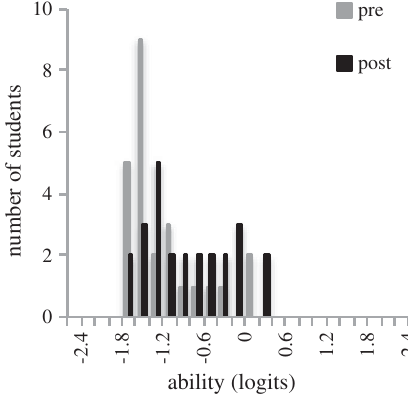
FIG. 41. The pre- and postability histogram for class 27.